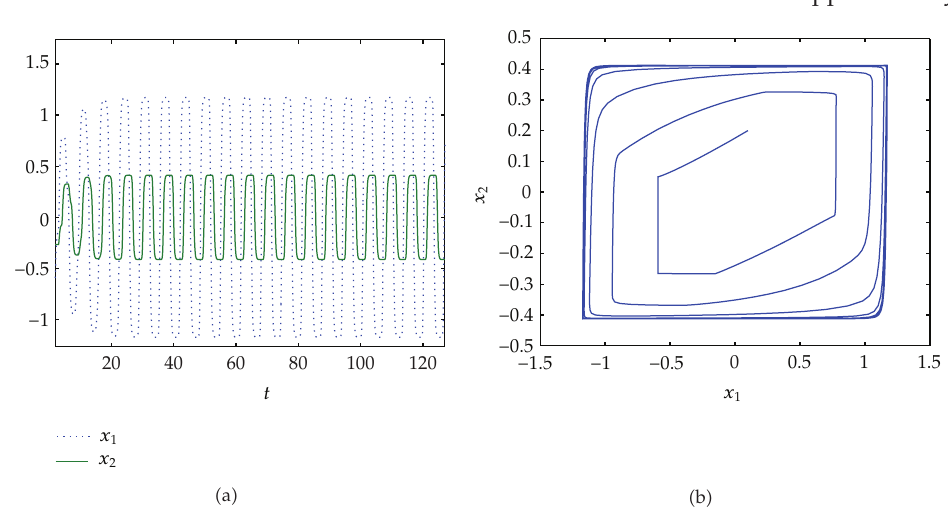
Figure 3: (cid:6) a (cid:7) Phase plot in space (cid:6) x 1 ,x 2 (cid:7) for system (cid:6) 4.1 (cid:7) with d 1 (cid:8) − 3 . 0. (cid:6) b (cid:7) Phase plot in space (cid:6) x 1 ,x 2 (cid:7) for system (cid:6) 4.1 (cid:7) with d 1 (cid:8) − 3 .